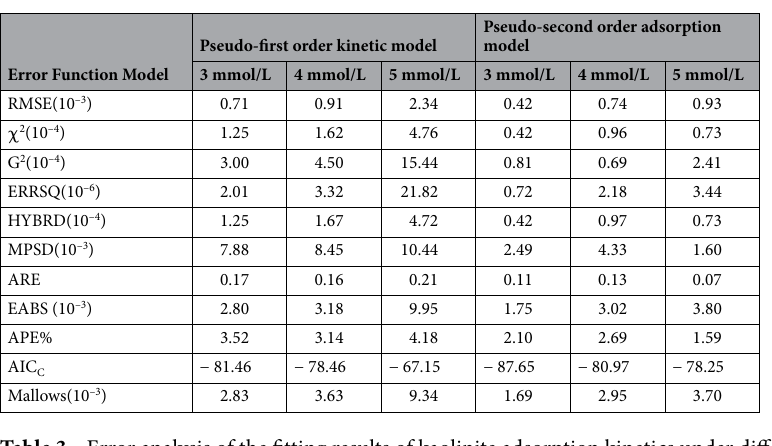
Table 3. Error analysis of the fitting results of kaolinite adsorption kinetics under different SDBS concentrations.